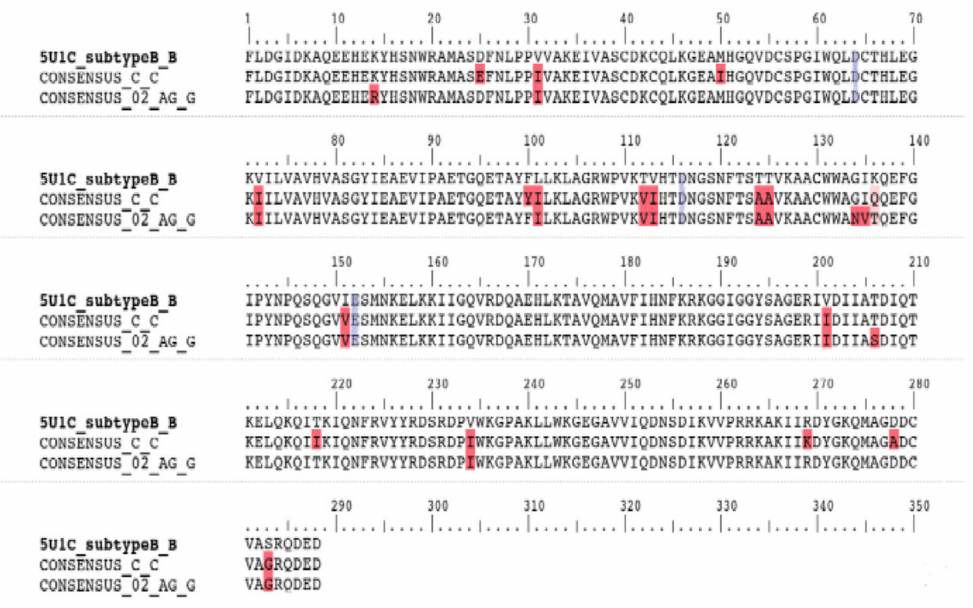
Figure1. Aminoacid sequencealignment ofintegrase variantssubtype B,subtype Cza, andCRF_02_AG, respectively. Red highlighted residues indicate polymorphism locations in comparison with the Subtype B template. Blue highlighted residues indicate the aspartate (D64), aspartate (D116) and glutamate (E152) DDE